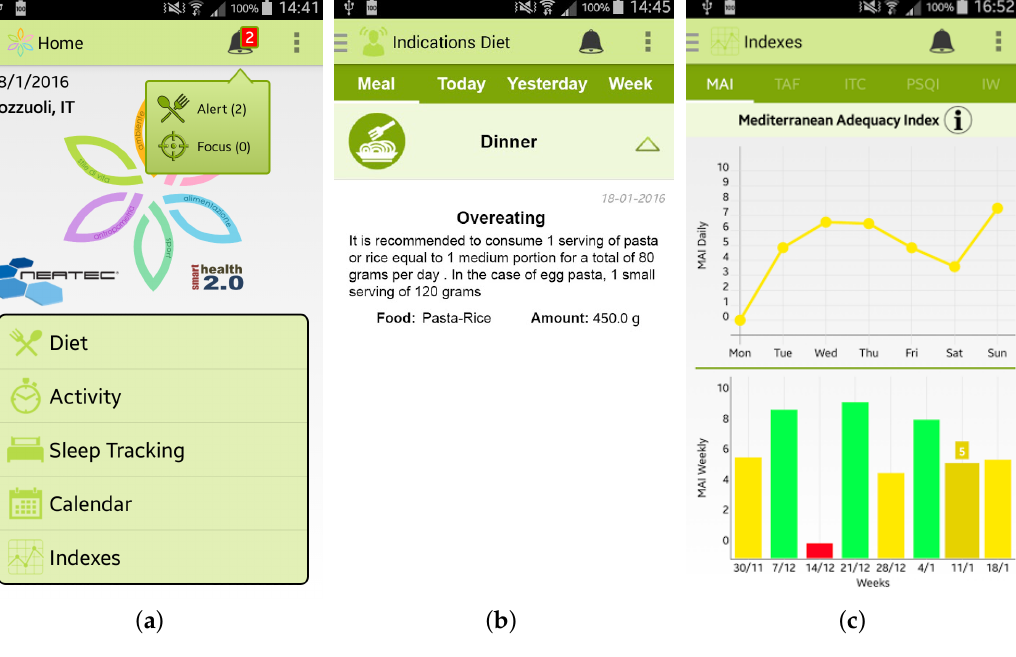
Figure 6. Screenshots of the Wellness App relating to the alerts and the statistics of the calculated indexes: ( a ) the main menu of the app where an alert is notified; ( b ) detailed view of the alert; and ( c ) daily and weekly trends of the Mediterranean Adequacy Index